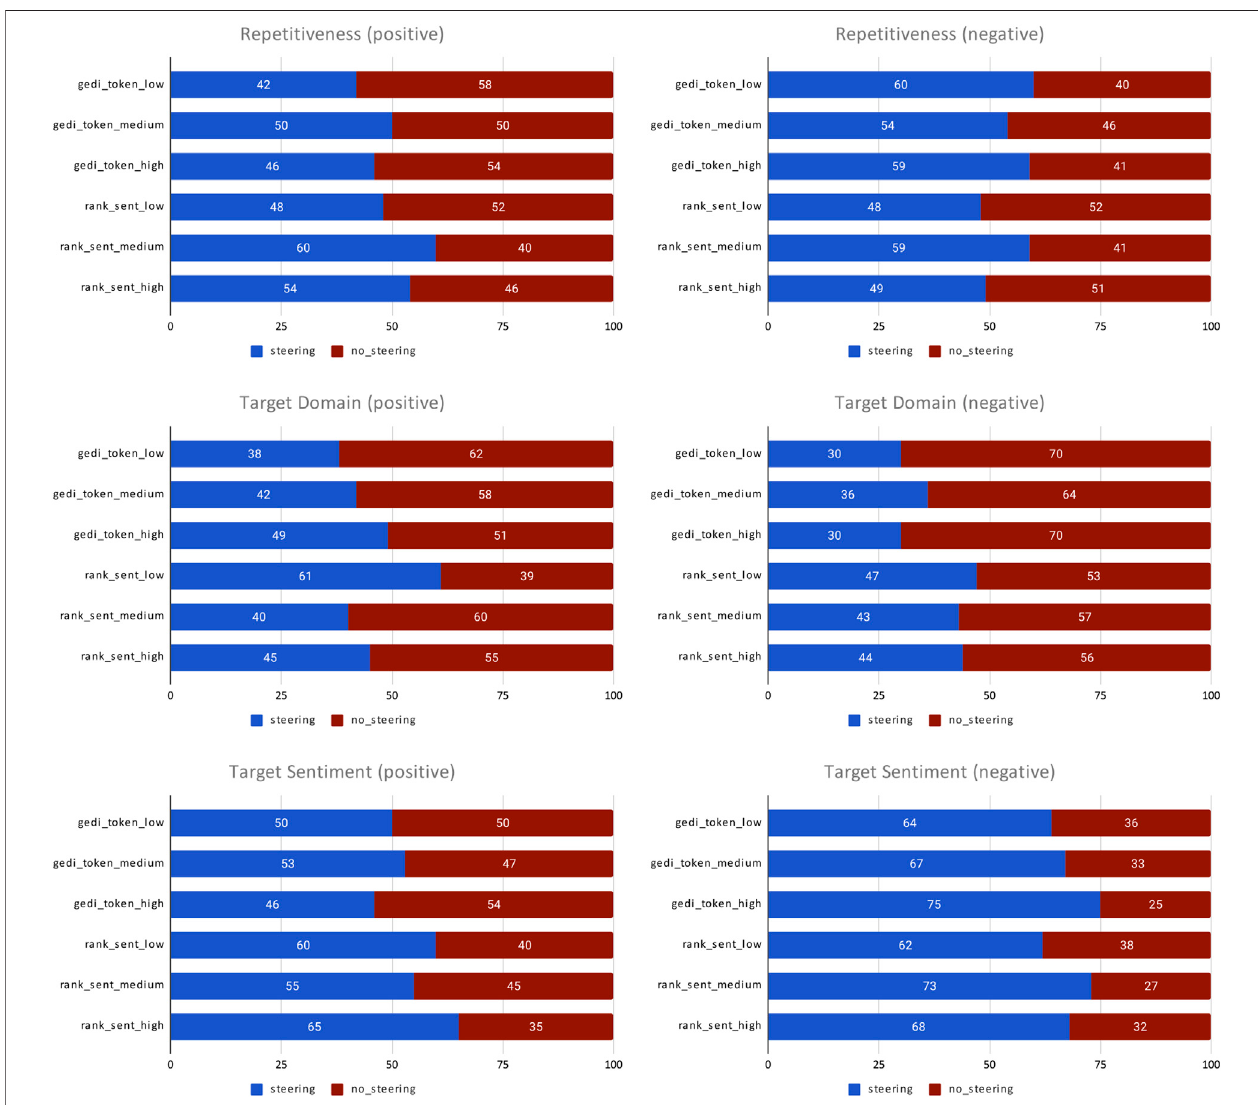
FIGURE 11 | Human evaluation of self-chat stories with sentiment steering, comparing various systems against a tuned baseline without steering. The preferred system is indicated by a larger portion of the bar.